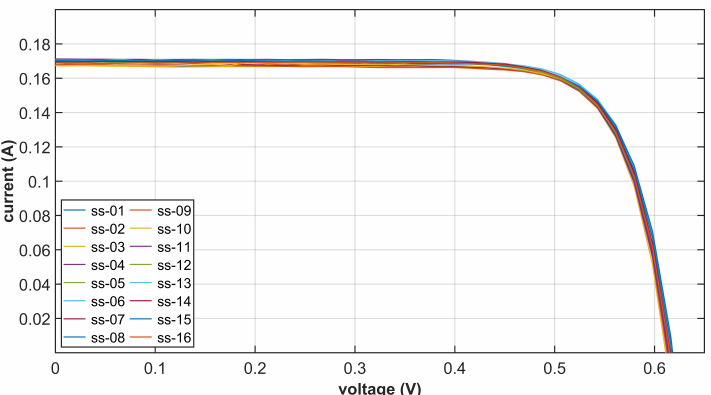
Figure 4. The volt-ampere curve of each solar cell under perpendicular illumination of the artificial sunlight. Solar cells with similar photoelectric characteristics are